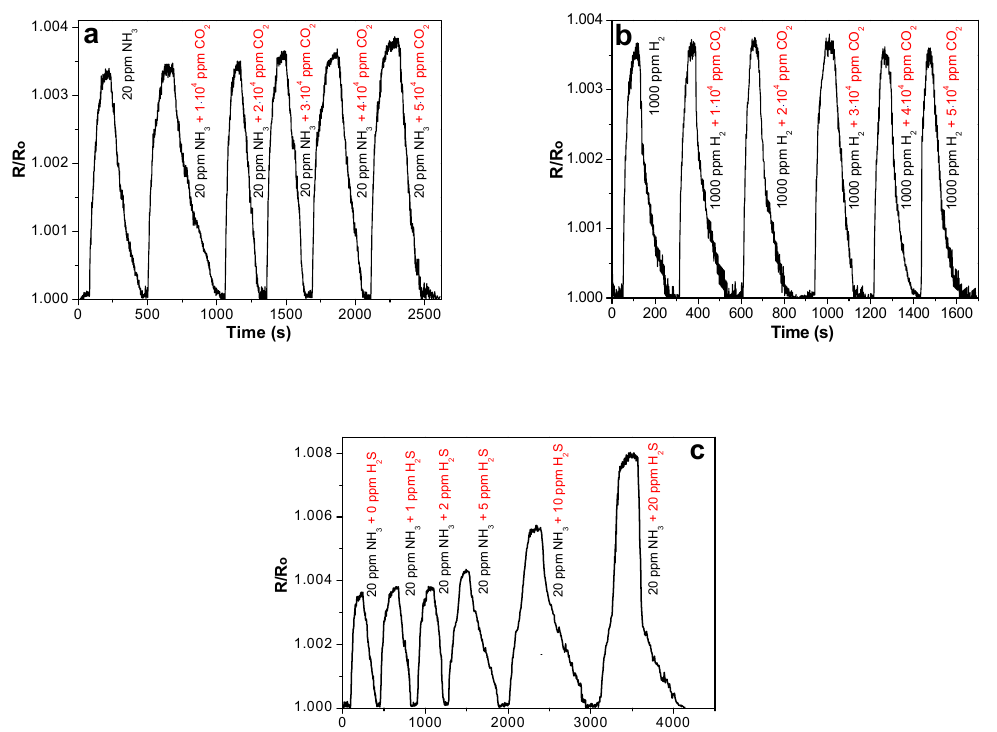
Figure 10. Sensor response of SWCNT/SiPc hybrid layers to different analytes.